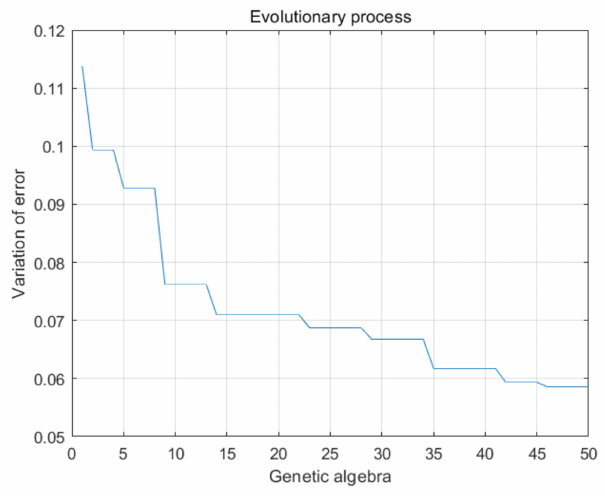
Figure 22. Optimization process of genetic